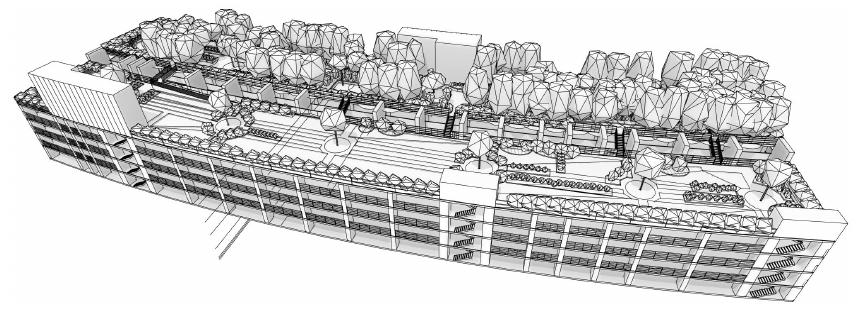
Figure 17. The information-enriched 3D vegetation models are imported as an IFC file into Revit.